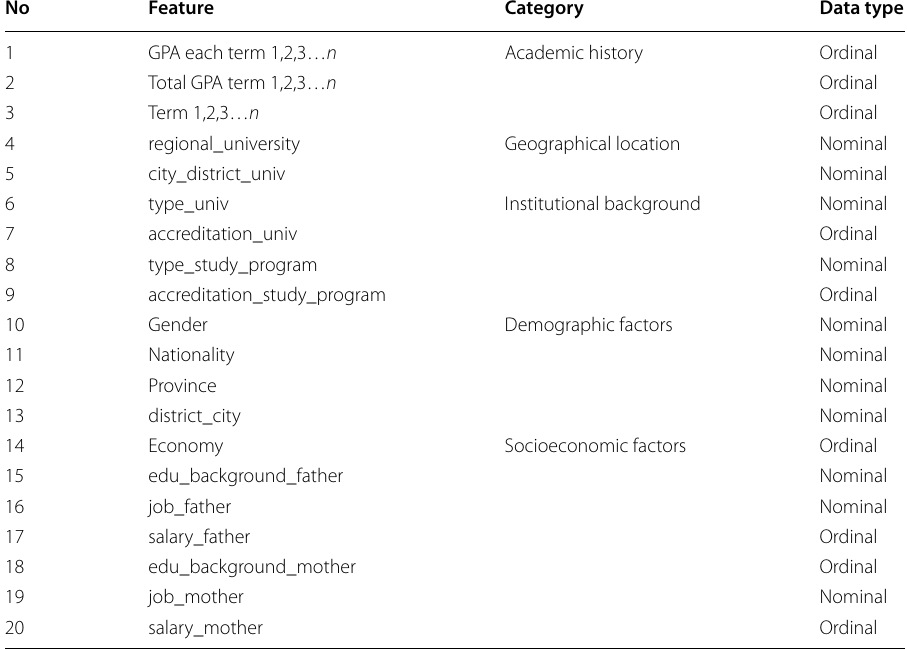
Table 2 Dataset structure before one-hot